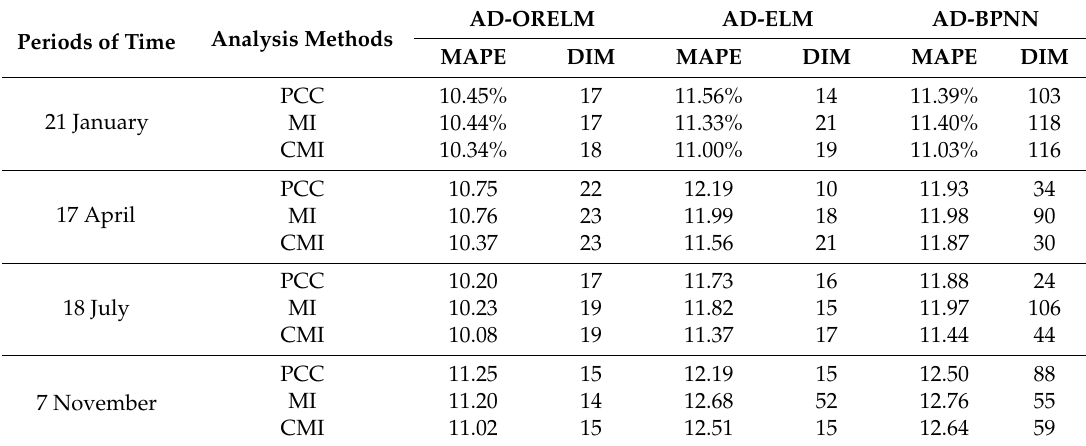
Table 5. The optimal feature subsets of different predict days obtained with AD data.